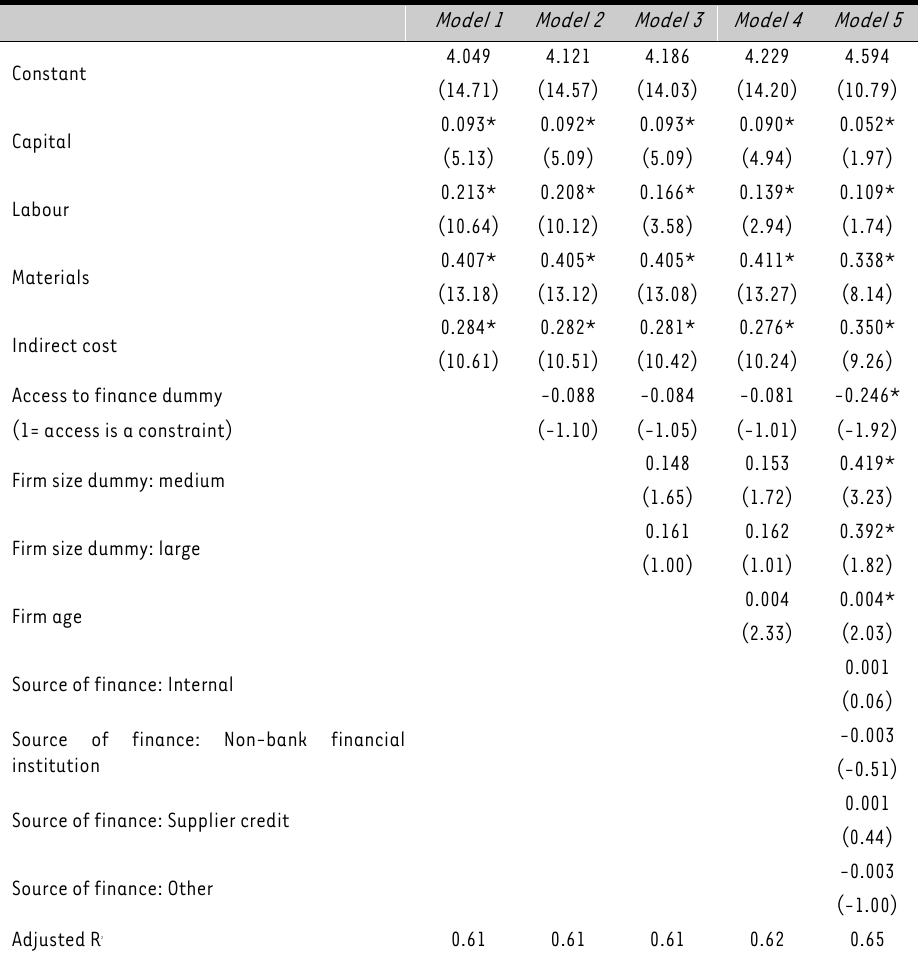
TABLE 7: Regression